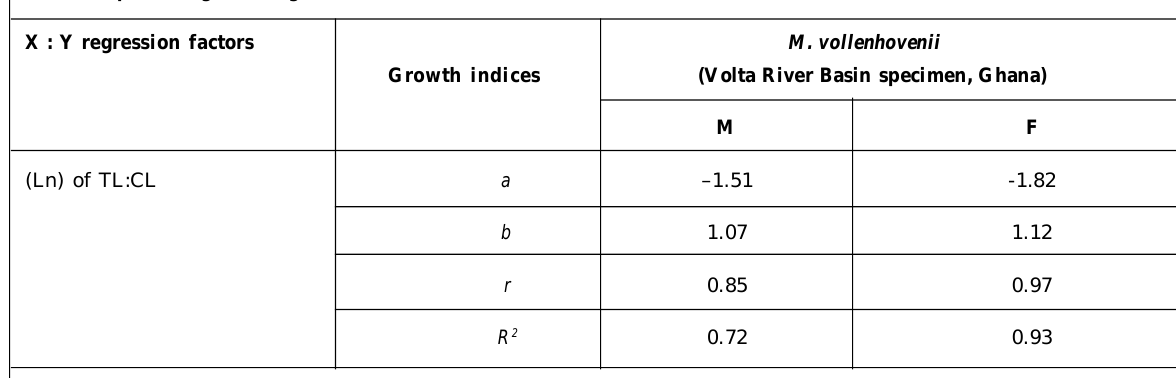
Table 5: Morphometric relationship of M. vollenhovenii collected from Lower Volta River, Ghana using total length and carapace length as regression factors